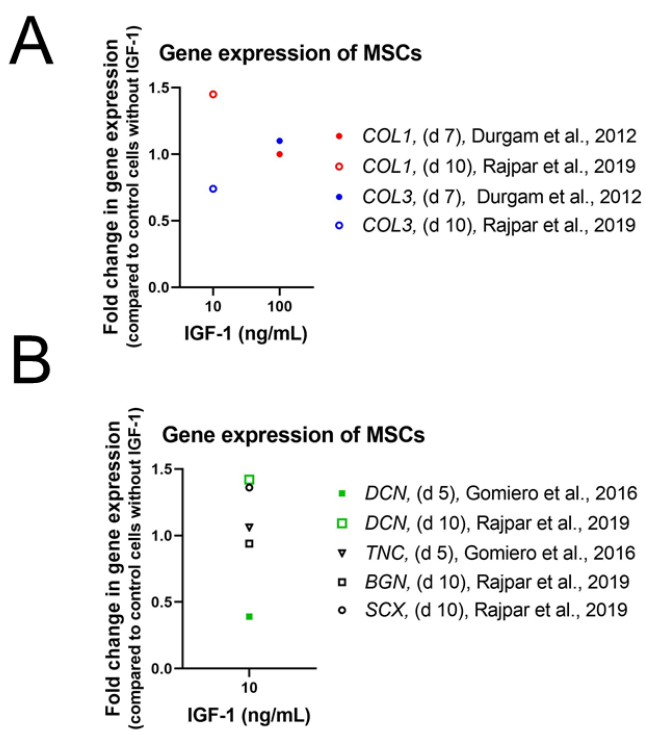
Figure 4. Impact of IGF-1 concentration on the gene expression of collagen I and III ( COL1 and COL1 ) ( A ), Decorin ( DCN ), Tenascin-C ( TNC ), Biglycan ( BGN ) as well as Scleraxis ( SCX ) ( B ) after 5, 7, or 14 days in equine mesenchymal stem cell culture in high-glucose DMEM containing 10% FBS and AA (37.5 µg/mL) [76]; equine MSCs in high-glucose DMEM containing 10% FBS and AA (37.5 µg/mL) [88]; and equine tenocytes in DMEM containing 20% FCS [87].